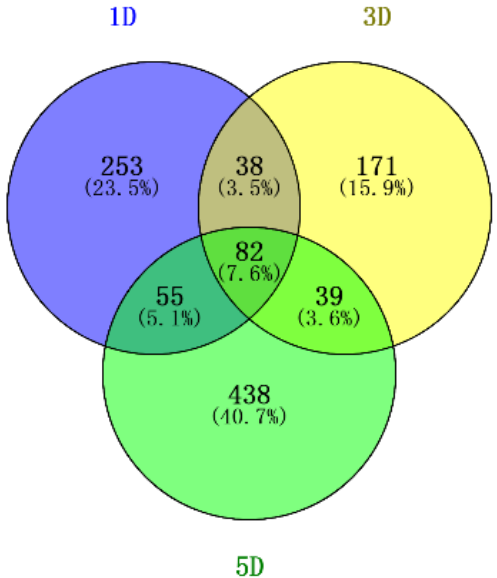
Figure 1. Venn diagram of DEGs identified from two diploid cotton accessions; 1D, 3D, 5D repre- 1 Days post-anthesis (DPA), 3 DPA, 5 sents 1 Days post-anthesis (DPA), 3 DPA, 5 DPA.